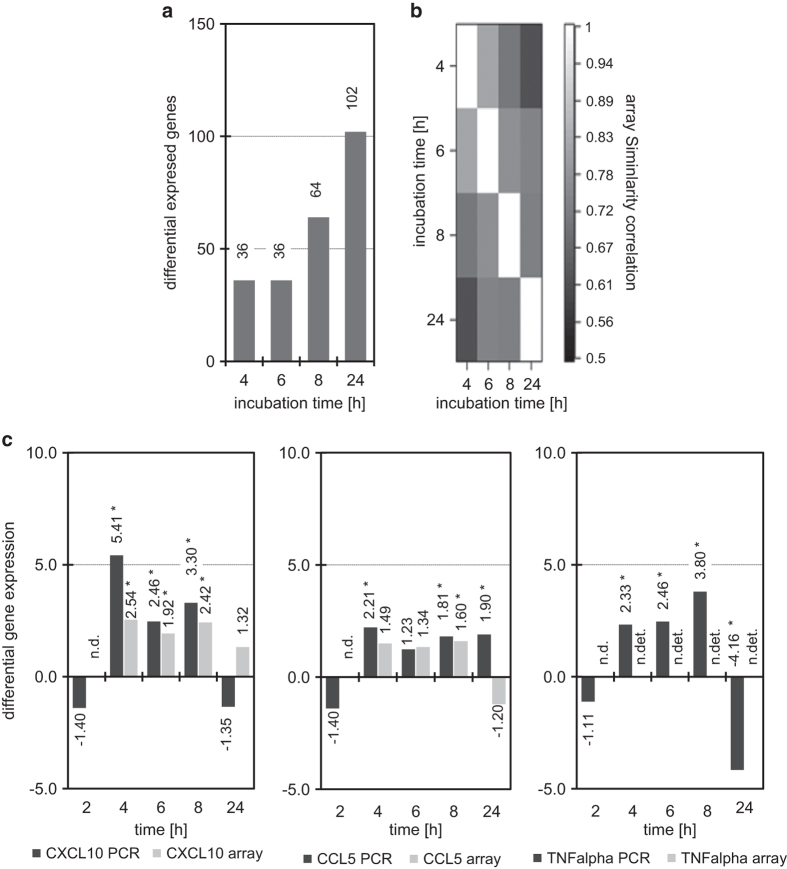
Synthetic ceramide analogs affect differential gene expression in HT-29 cells. HT-29 cells were treated 2, 4, 6, 8 and 24 h with 30 μM HPL-1R36N (6) and HPL-1S36N (7). (a) Differential expressed genes in total RNA of HT-29 cells. Total RNA of cells treated 4, 6, 8, 24 h with HPL-1R36N (6) and HPL-1S36N (7) were transcribed and labeled separately, however, co-hybridized on the same array. (b) Array similarity matrix of hybridized oligonucleotide arrays. Therefore, array dissimilarity in similarity matrix (Pearson’s sample correlation) shows similar behavior as differential gene expression caused by the individual enantiomers. (c) CXCL10, CCL5 and TNF-alpha: three prominent differentially expressed genes in real-time PCR (2, 4, 6, 8, 24 h) and spotted oligonucleotide microarray (4, 6, 8, 24 h) on treatment of HT-29 cells with synthetic ceramides. Significance is supposed, if numerical value of differential gene expression >1.5 fold. Not determined (n.d.), not detectable (n.det.) due to low specific mRNA concentration.